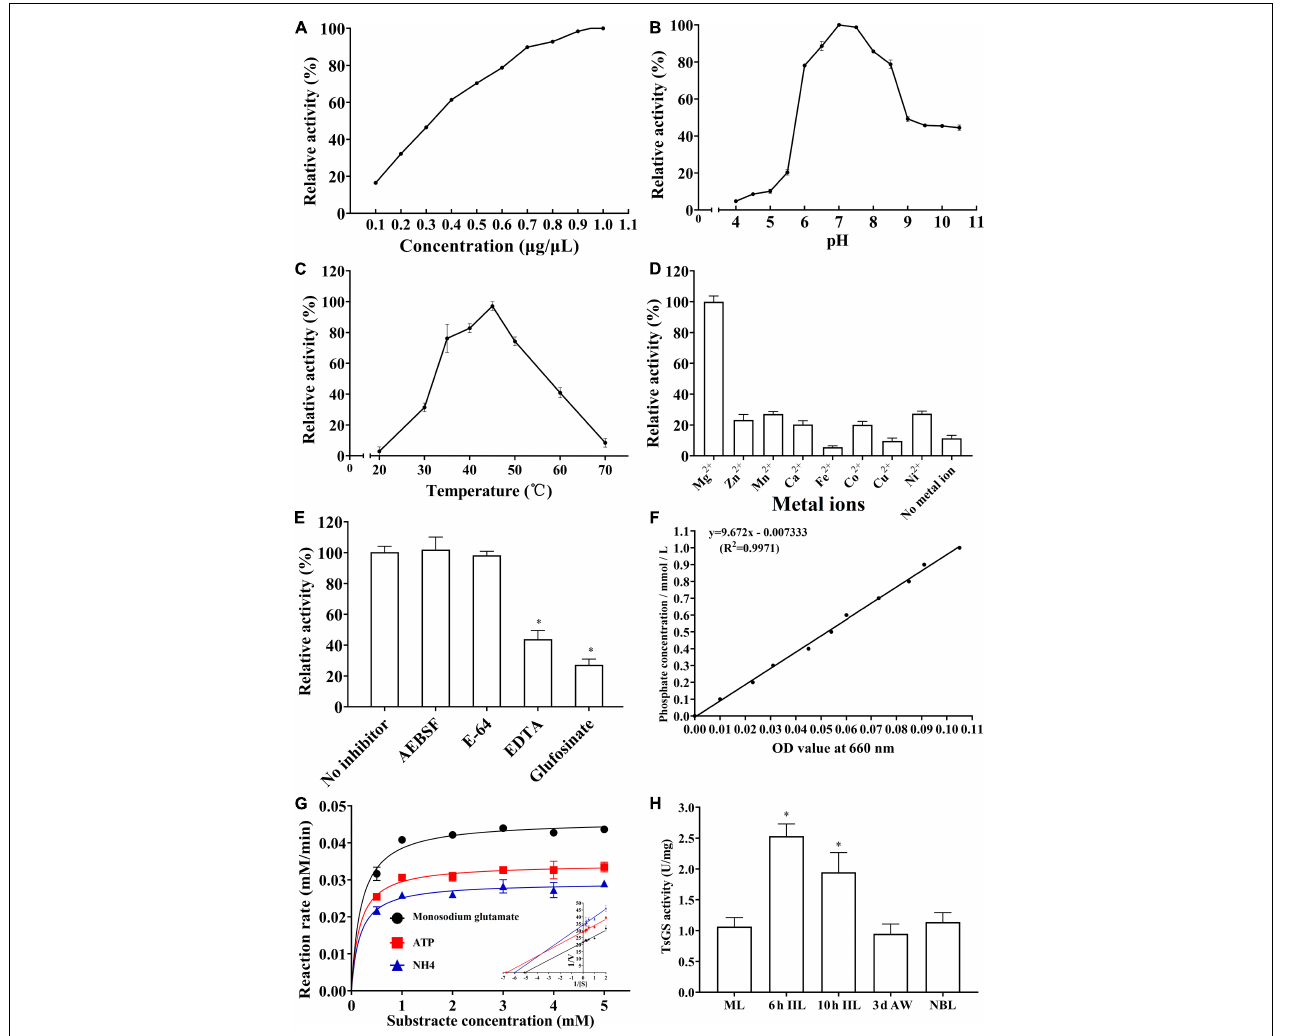
FIGURE 7 | Enzymatic activities of rTsGS. rTsGS was first re-naturated by dilution refolding method. The diluted rTsGS (0.05–1.00 µ g/ µ l) was incubated at 35 ◦ C for 15 min in various pH buffer (pH 3.0–10.5); subsequently, the glutamine synthetase substrates (Glu, ATP, and NH 4 + ) were added to the reaction mixture and incubated at various temperatures (20–70 ◦ C) for 30 min, and the absorbance at 660 nm was measured with a spectrophotometer. (A) rTsGS enzyme activity at different rTsGS concentrations; the optimal concentration was 0.95 µ g/ µ l. (B) rTsGS activity at different pH values; the optimal pH was 7.0. (C) rTsGS activity at different temperatures; the optimal temperature was 45 ◦ C. (D) Effects of different metal ions on rTsGS activity; the rTsGS activity is dependent on Mg 2 + . (E) Suppression of different inhibitors on rTsGS activity. * P < 0.01 compared to the no inhibitor, AEBSF and E-64 groups. (F) Standard curve of phosphorus. (G) Michaelis–Menten curve and Lineweaver–Burk at pH 7.0, 45 ◦ C, and 100 mM Mg 2 + . (H) TsGS enzyme activity of various Trichinella spiralis stages. * P < 0.01 compared to other three worm stages.